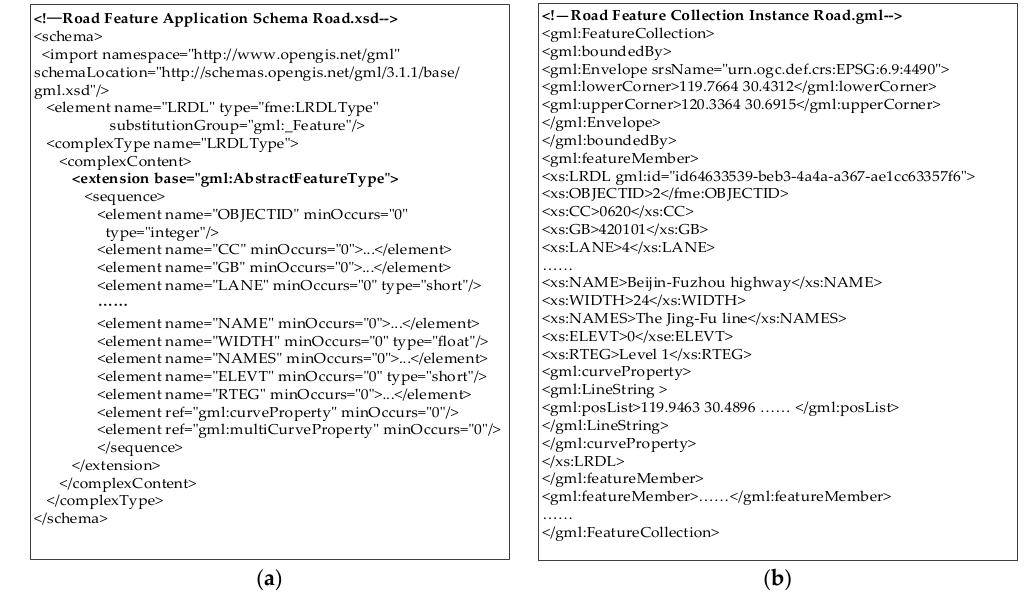
Figure 1. ( a ) Road application schema file; ( b ) road instance data document.